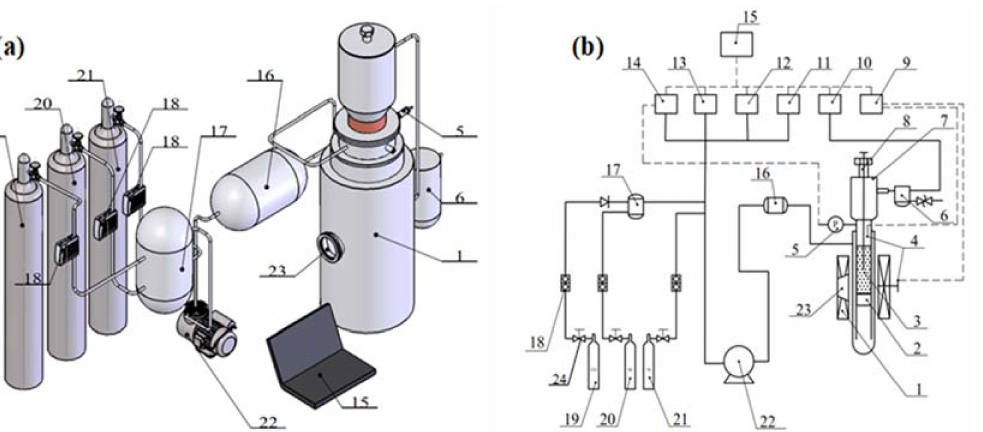
Figure 1. Experimental setup: ( a ) fluidized bed reactor; ( b ) flow chart. 1. Gas mixing and preheating